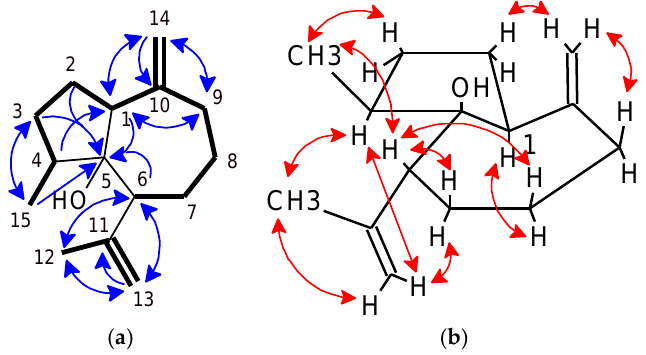
Figure 4. ( a ) COSY correlations (bold) and HMBC (blue arrows) key correlations of compound ( 23 ); ( b ) Selected NOE (red arrows) correlations of compound ( 23 ).